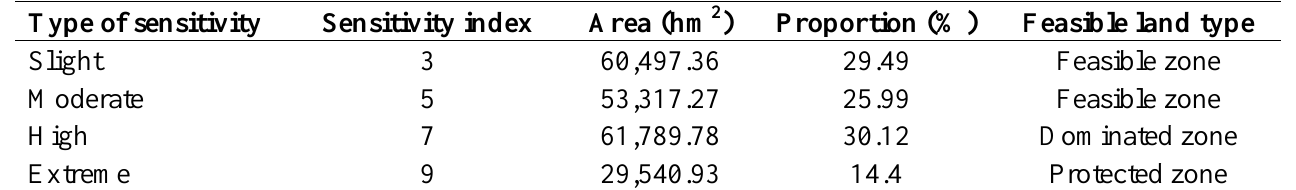
Table 6. Synthetic eco-environment sensitivity evaluation results for Yicheng